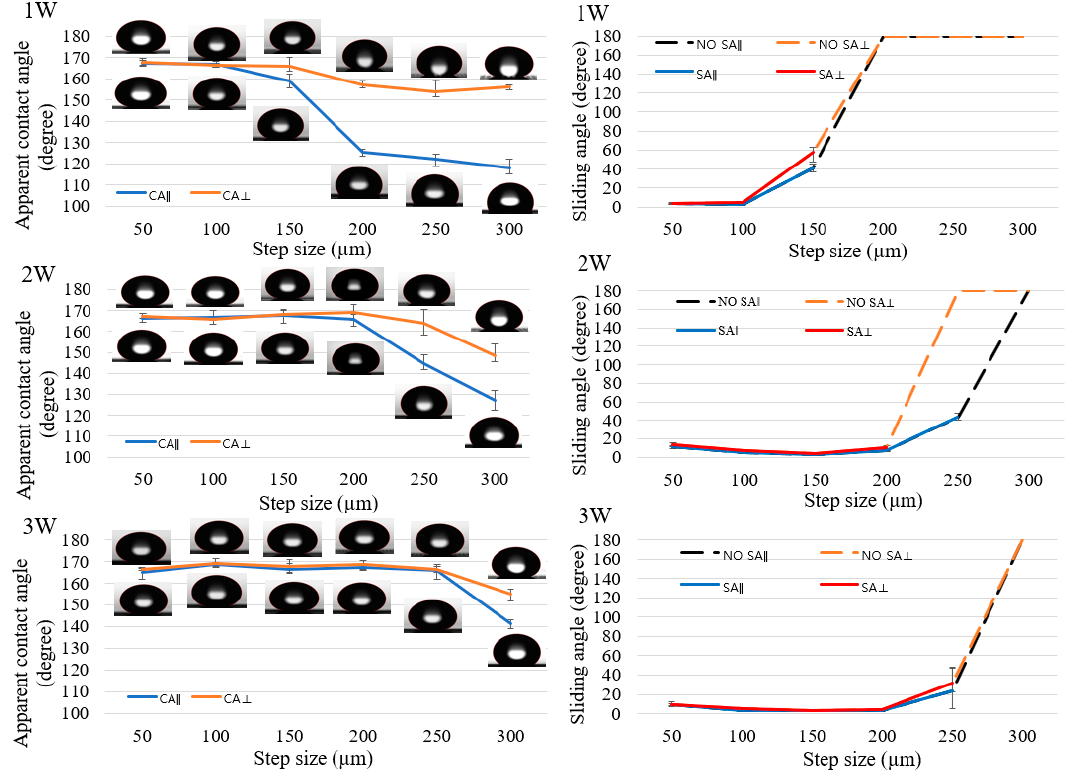
Figure 6. Measurement of the water droplet contact and sliding angle of line-patterned samples with two directions: parallel direction (blue color) and perpendicular direction (orange color) at laser power of 1, 2, and 3 W.